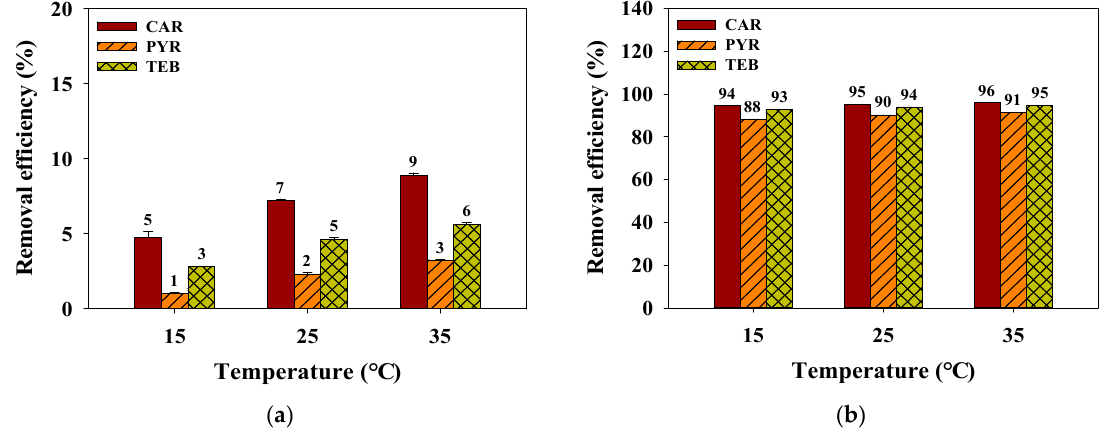
( b ) Figure 7. The effects of the pH on the adsorption of fungicides by ( a ) the PSB and ( b ) PSB OX-A (agitation speed = 150 rpm; contact time = 24 h; absorbent dosage = 50 mg L − 1 ; initial concentration of each fungicide = 10 μ M; temperature = 25 °C). 3.6. Effects of Temperature and Thermodynamic Studies